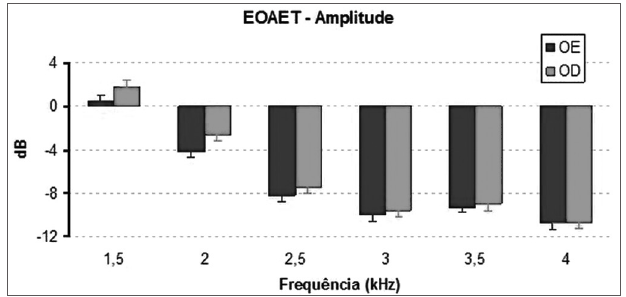
Figura 2. Média e desvio padrão das amplitudes das EOAT registra- das para cada orelha em cada frequência. OE: Orelha esquerda; OD: Orelha direita. Teste ANOVA, p = 0,009.